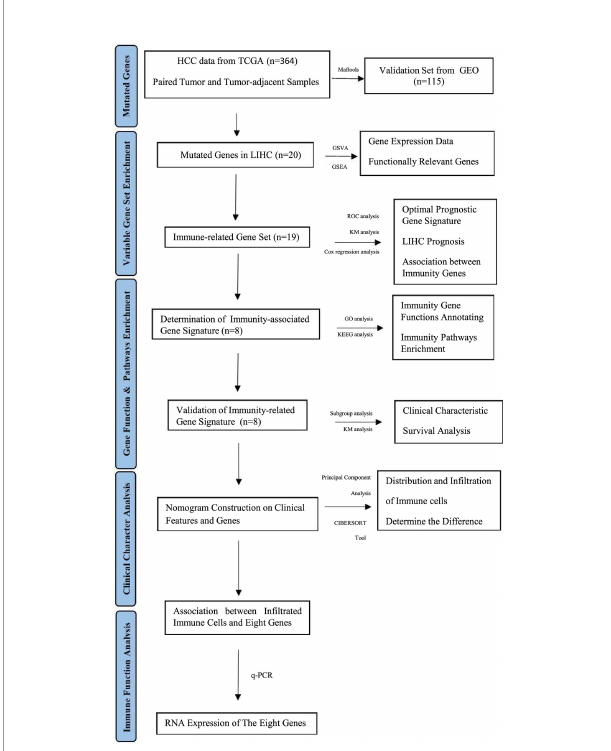
FIGURE 1 | Bioinformatics Algorithm of prognostic gene set for hepatocellular